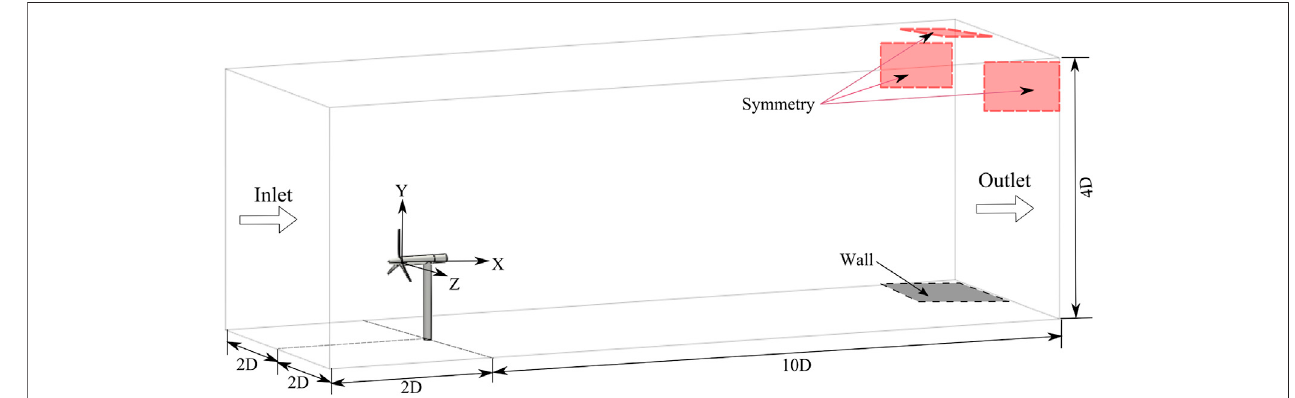
FIGURE 3 | Physical domain used in the study.